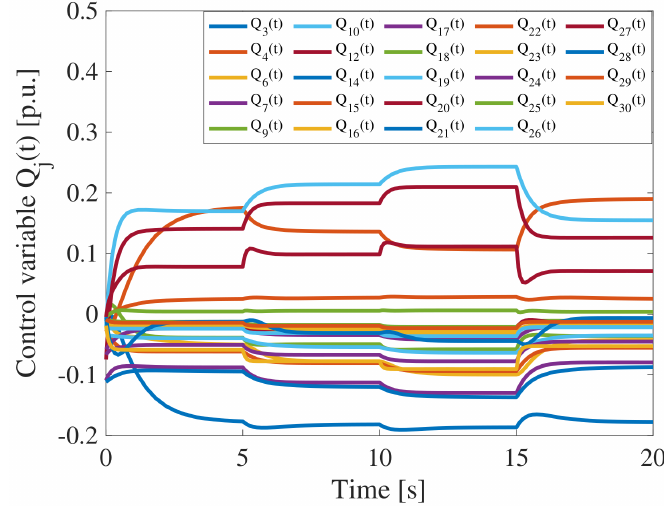
Figure 8. Robustness with respect to variable load: time history of the reactive power Q j ( t ) [ p . u . ] for j ∈ N c